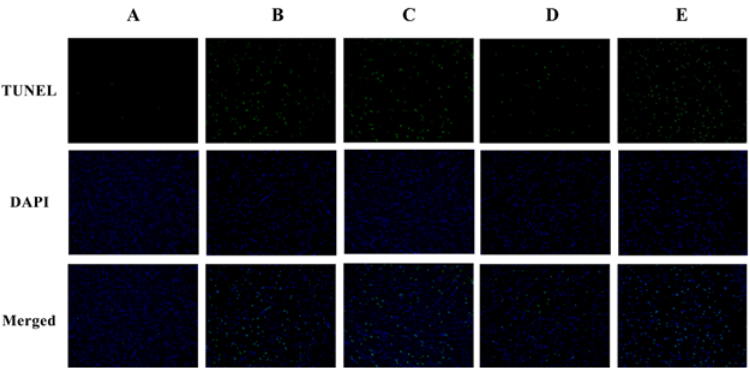
Figure 5. Representative photographs of terminal deoxynucleotidyl transferase-mediated deoxyuridine 5-triphosphate-biotin end labeling (TUNEL) staining (100×). ( A ) control group; ( B ) SA group; ( C ) low dose TGP group; ( D ) high dose TGP group; ( E ) positive group.